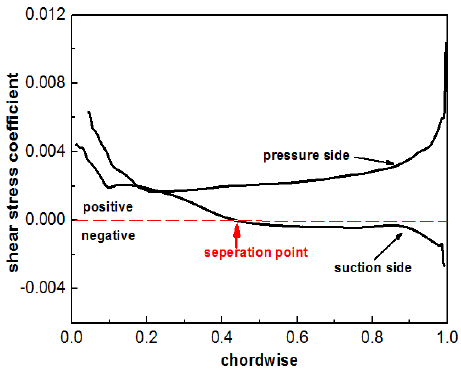
Figure 9. Wall shear stress distribution on the rotor blade surface.